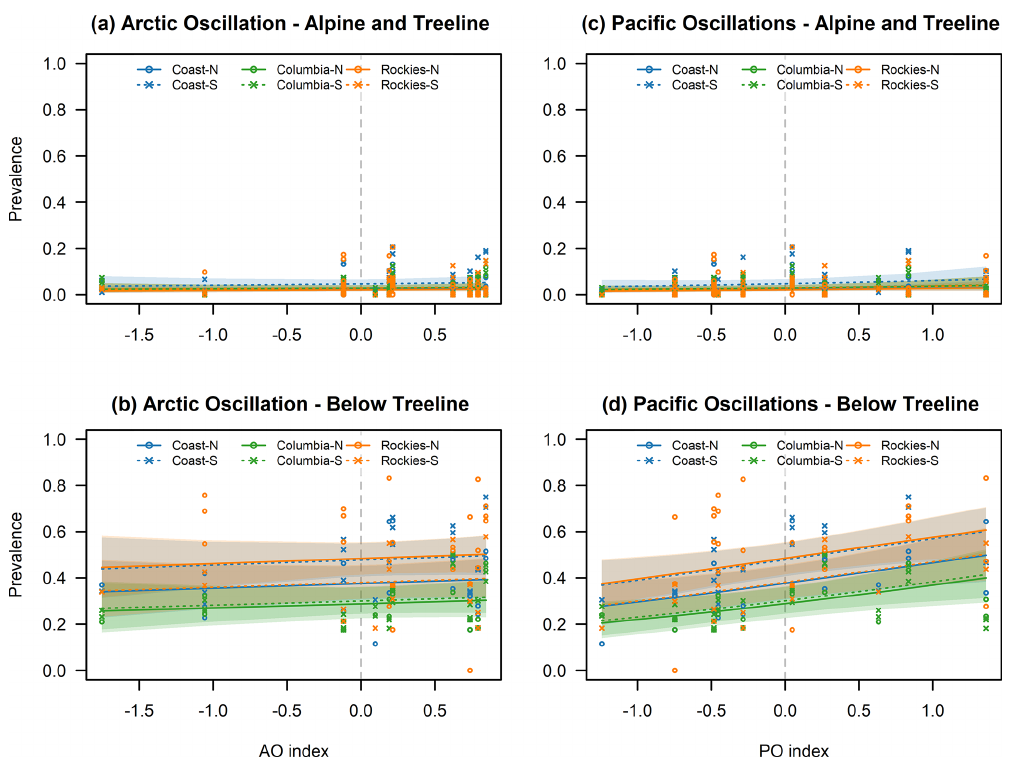
Figure 7. Calculated prevalence for no avalanche problems in relation to AO (a, b) and Pacific-centered oscillations (c, d) for the alpine/treeline (a, c) and below treeline (b, d) over the range of observed index values. Lines indicate the mean estimates, and shaded areas represent the 95% confidence intervals. Individual points represent observed prevalence